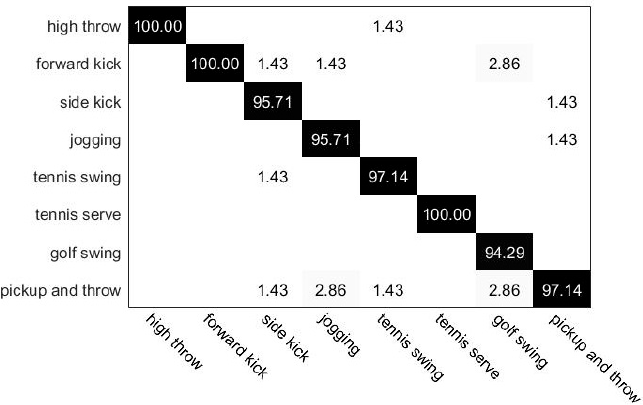
Figure 5. Confusion matrix of our proposed method in AS3.